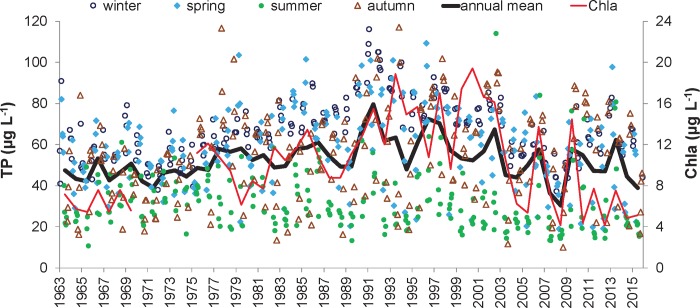
Time-series of total phosphorus (TP) and chlorophyll-a (Chla) concentrations in the Slapy Reservoir during 1963–2015.The black line is the annual average TP concentration; points are individually measured TP concentrations with indicated sampling seasons; the red line is the annual average concentration of Chla.